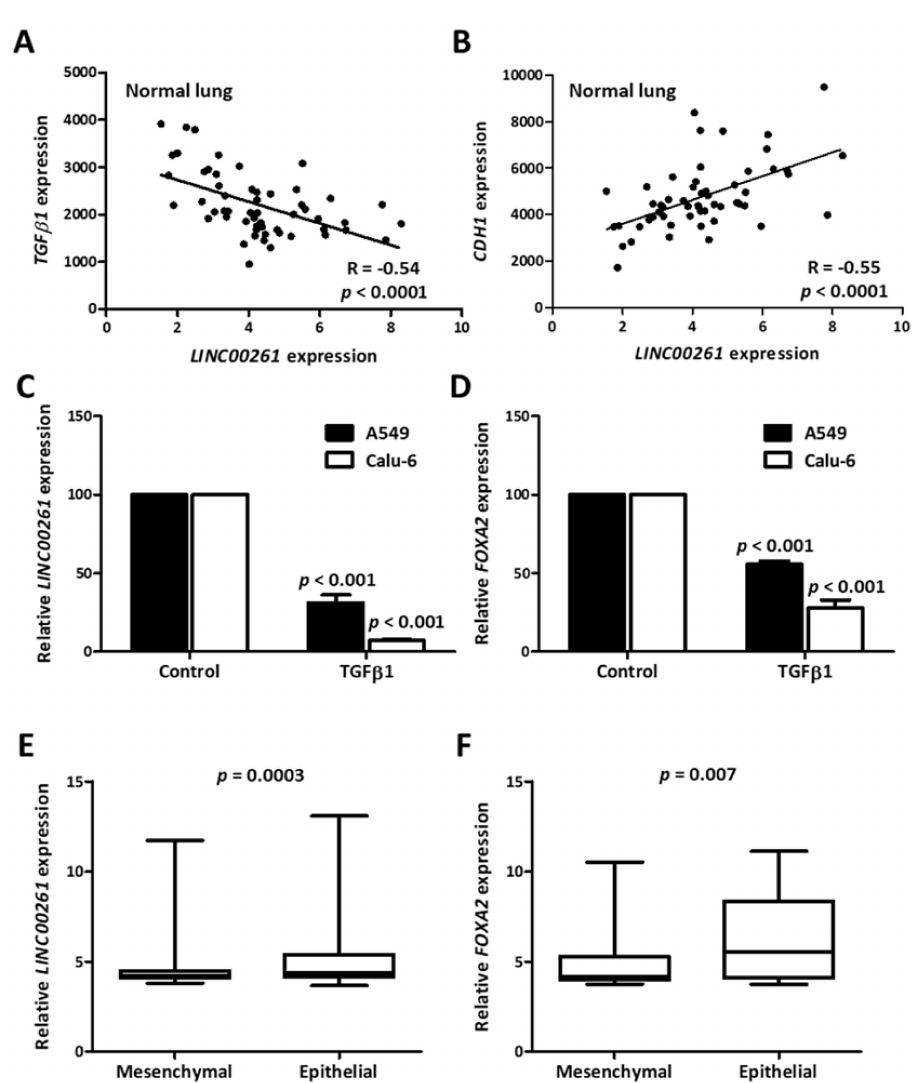
Figure 4. LINC00261 and FOXA2 are indicative of an epithelial gene signature in normal lung and lung cancer cell lines. ( A , B ) Correlation plots showing strong correlation between LINC00261 and TGF β 1 ( A )/ CDH1 . ( B ) Expression in normal lung samples. ( C , D ) LINC00261 ( C ) and FOXA2 ( D ) are downregulated during TGF β -induced epithelial-to-mesenchymal transition (EMT) in A549 and Calu-6 lung cancer cell lines ( n = 3). p -value was calculated using ANOVA test. ( E , F ) The expression of LINC00261 ( E ) and FOXA2 ( F ) is stronger in the epithelial cluster of lung cancer cell lines generated by hierarchical clustering based on a previously established EMT signature ( n = 62 mesenchymal/123 epithelial cell